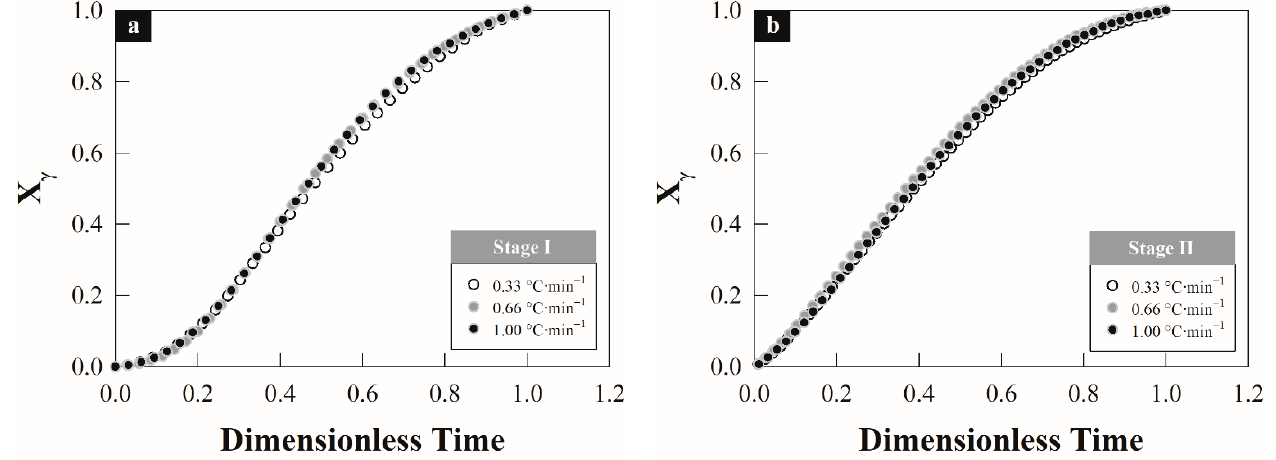
Figure 6. Behavior of the austenite formation degree by stages as a function of dimensionless time at different heating rates: 0.33, 0.66 and 1.00 °C·s − 1 : ( a ) stage–I and ( b ) stage–II.